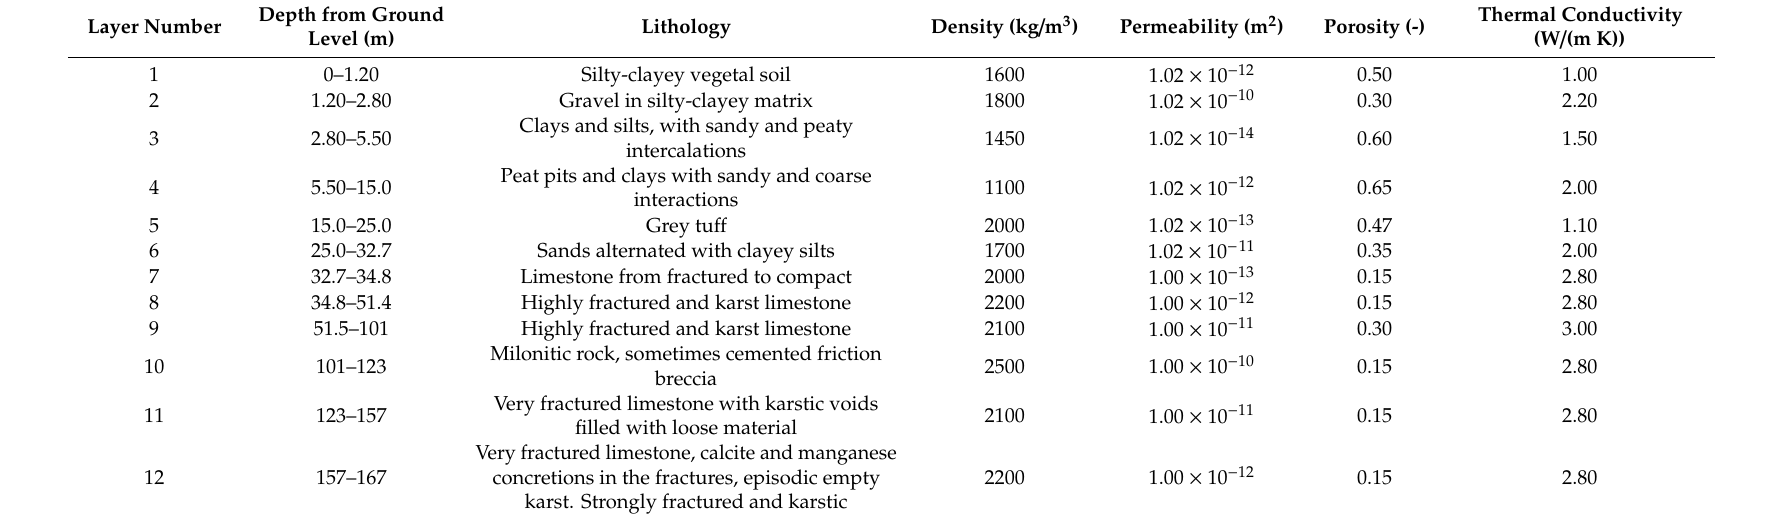
Table 2. Geothermal stratigraphy and geophysical properties of the layers composing the analyzed